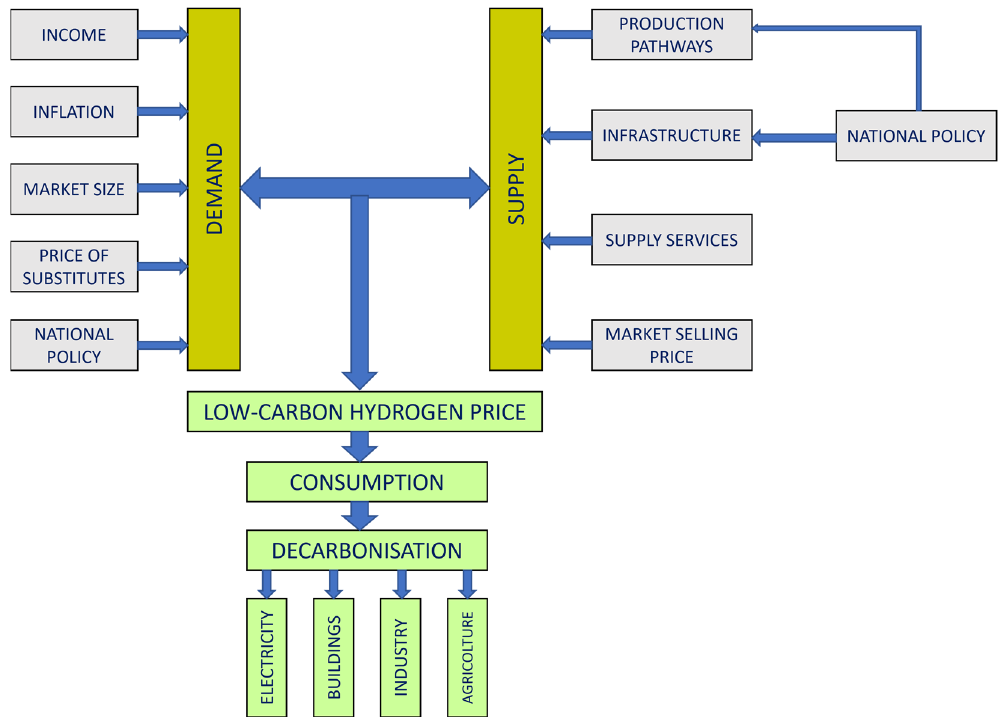
Figure 1. Relationships between the factors that determine uptake of green hydrogen and role of a national policy/strategy.